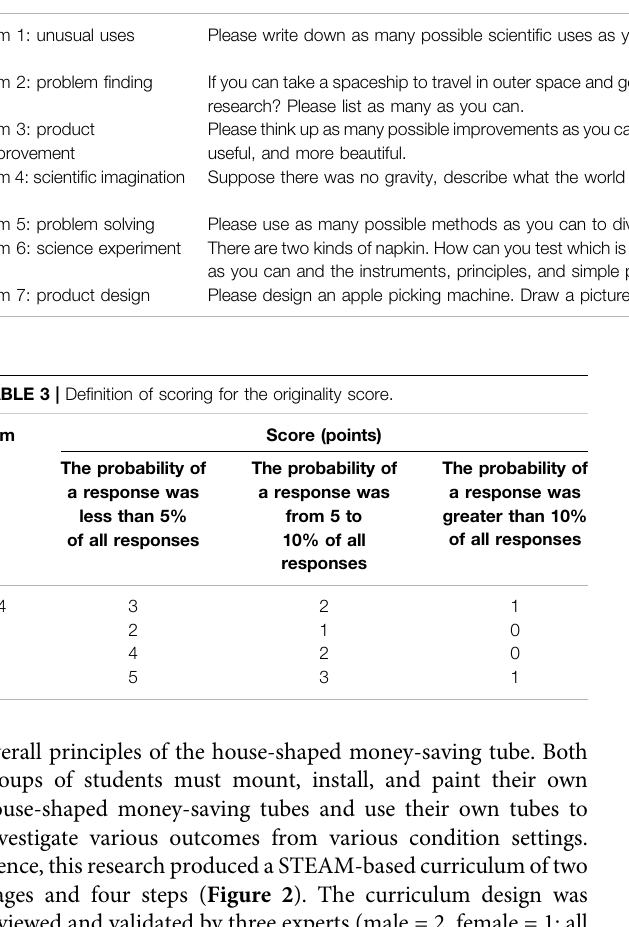
TABLE 2 | The scienti fi c creativity test (Hu and Adey, 2002; Huang and Wang, 2019). Item